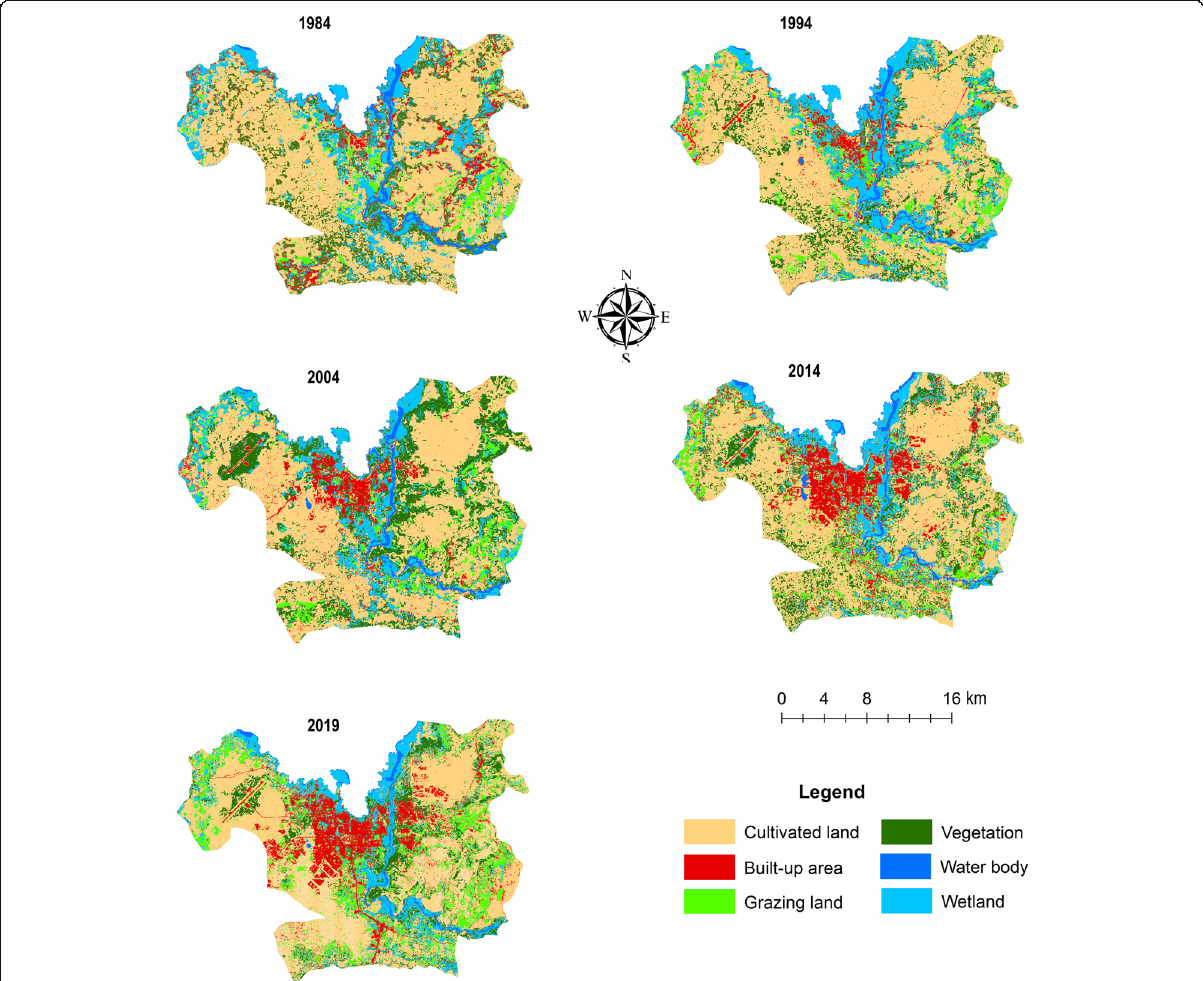
Fig. 2 The land use/land cover ( LULC) map of the study area from 1984 to 2019. The LULC map is derived from the Landsat Thematic Mapper (TM), Enhanced Thematic mapper Plus (ETM + ) and Operational Land Imager (OLI) satellite data